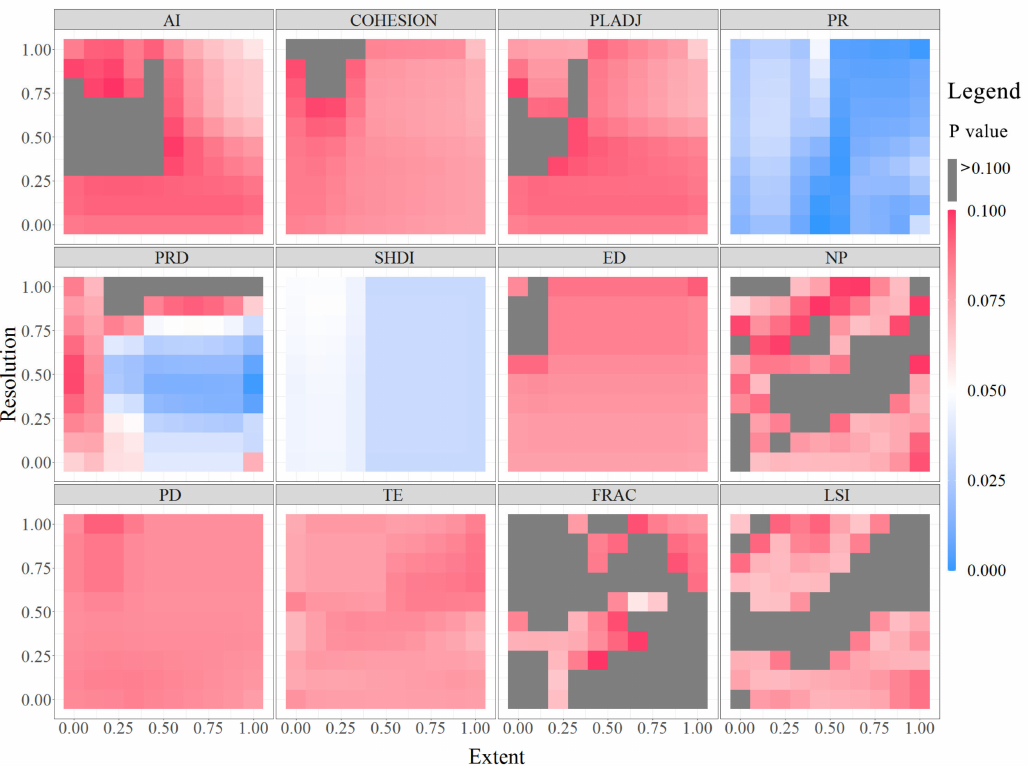
Figure A3. The linear changing trend significance of extent and resolution scaling sensitivity along the classification scale.